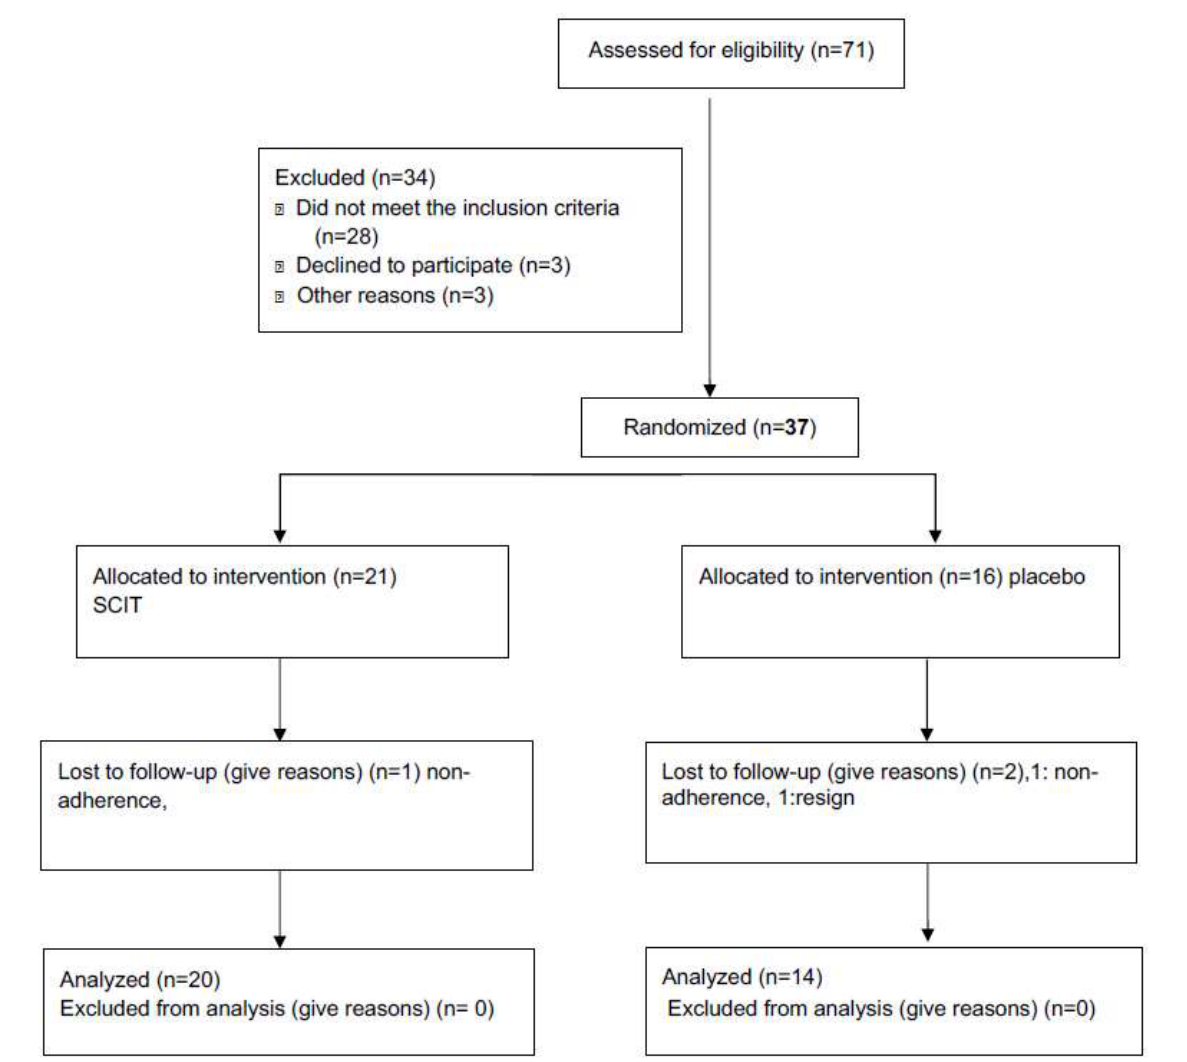
Figure 1. Number of participants assessed for eligibility that completed the study.